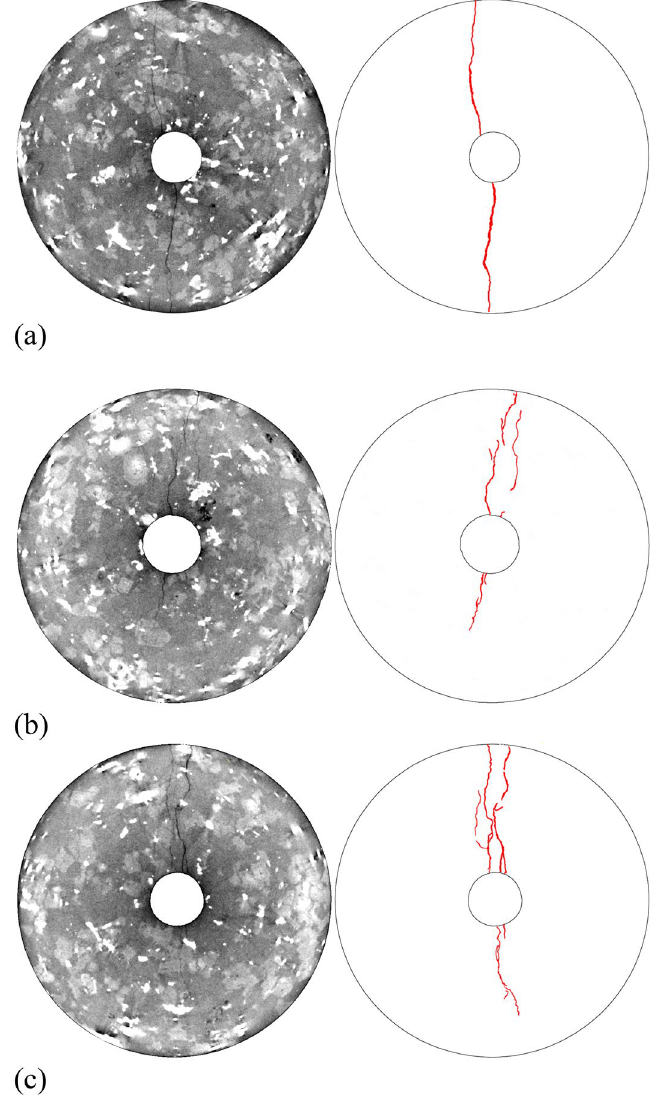
Figure 5. X-ray CT images (left) and fracture traces (right) after triaxial-injection tests on Pocheon granite cores (diameter: 50 mm; injection-borehole diameter: 8 mm). Continuous injection ( a ) led to single through- going bi-wing fractures, whereas cyclic injection with 43 cycles ( b ) and 150 cycles ( c ) led to multiple asymmetric fractures with a broader damage zone 49